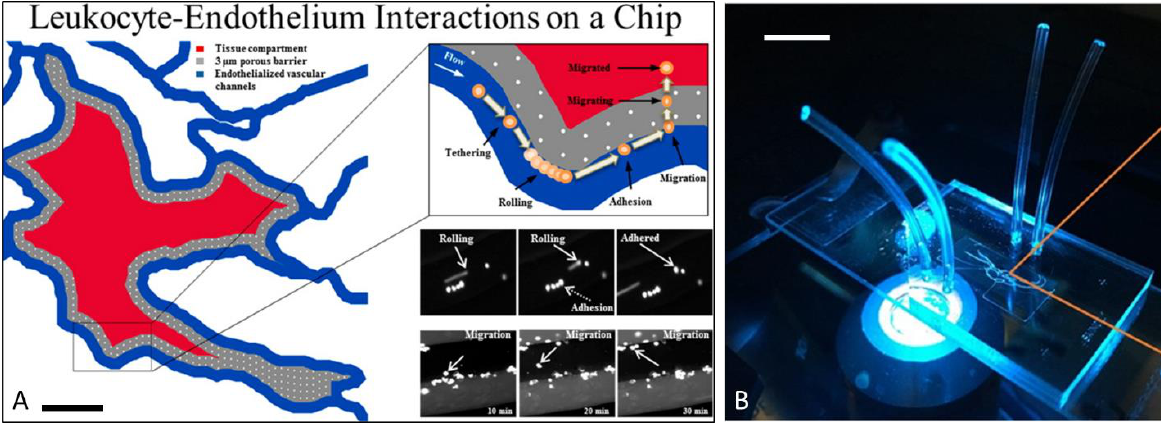
Figure 2. The biomimetic microfluidic assay (bMFA) mimics a physiologically relevant microvascular environment, which